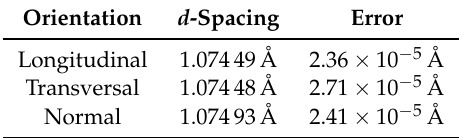
Table 1. Distribution of orthogonal d -spacing values of the reference cube.